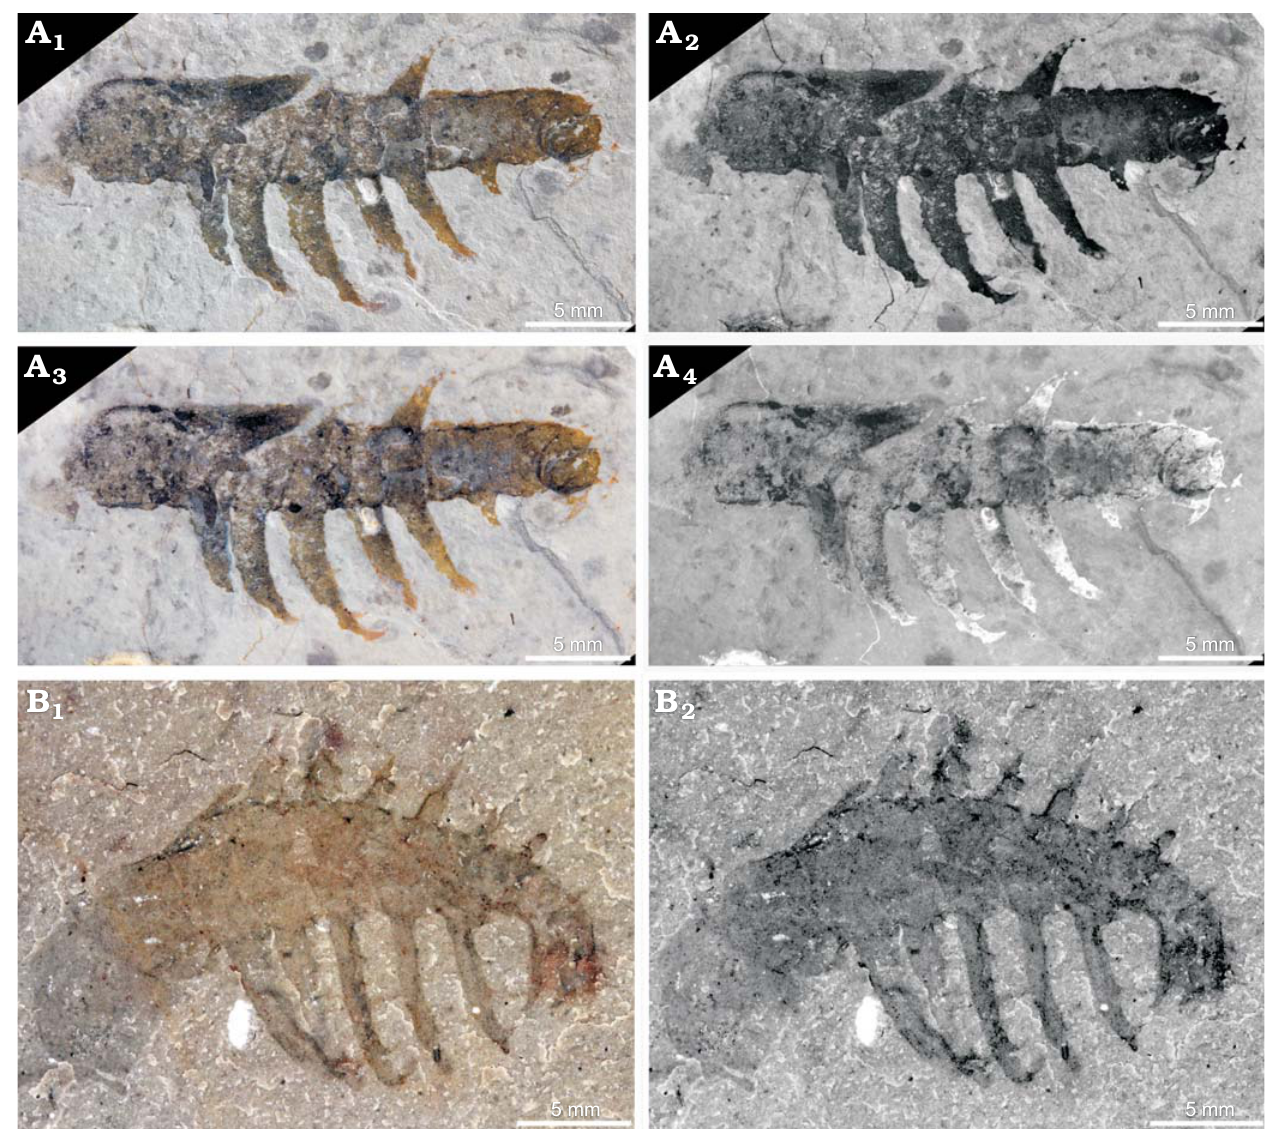
Fig. 1. A . Radiodontan euarthropod Stanleycaris sp., KUMIP 153923 from the Wheeler Formation (Cambrian Series 3, Drumian), Utah, USA; non-polarized ), cross-polarized light, red and yellow channels reduced (A light (A 1 B . Stanleycaris hirpex Caron, Gaines, Mángano, Streng, and Daley, 2010, ROM 59944 (holotype) from the Stephen Formation (Cambrian Series 3, Stage 5), British Columbia, Canada; cross-polarized light (B